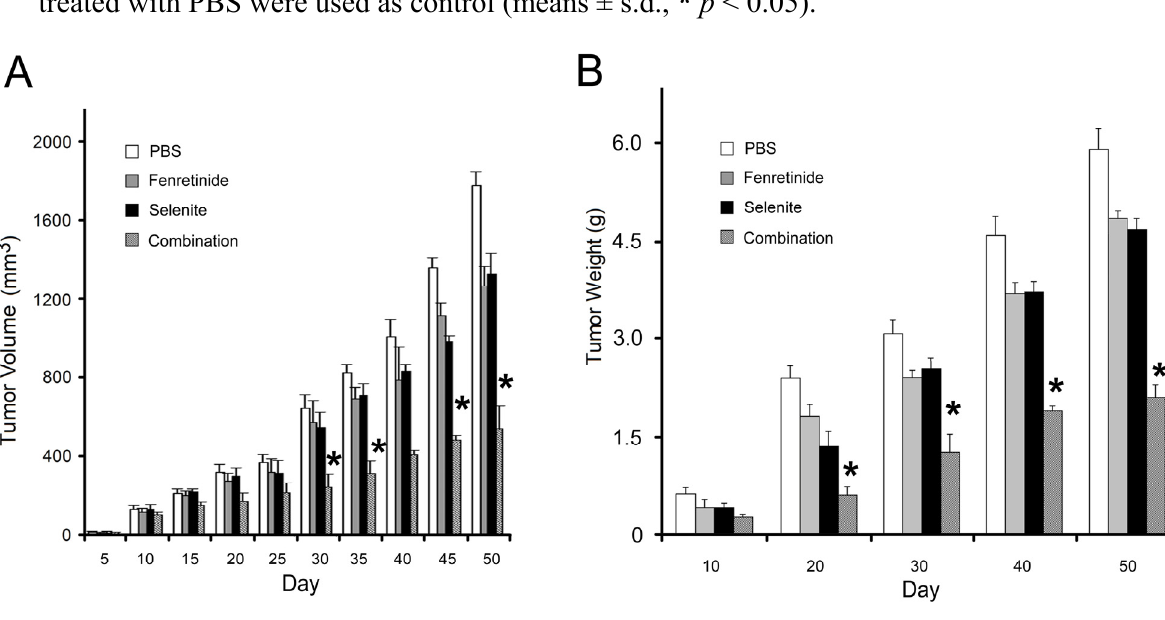
Figure 5. In vivo anti-tumor activity of fenretinide and selenite against SKOV3 cells-bearing model. Tumor volumes were measured every 5 days after initiating single drug or drug combination therapy ( A ); Tumor weight of tumor bearing mice received the drug alone or drug combination therapy was measured every 10 days ( B ). SKOV3 cells-bearing model treated with PBS were used as control (means ± s.d., * p <